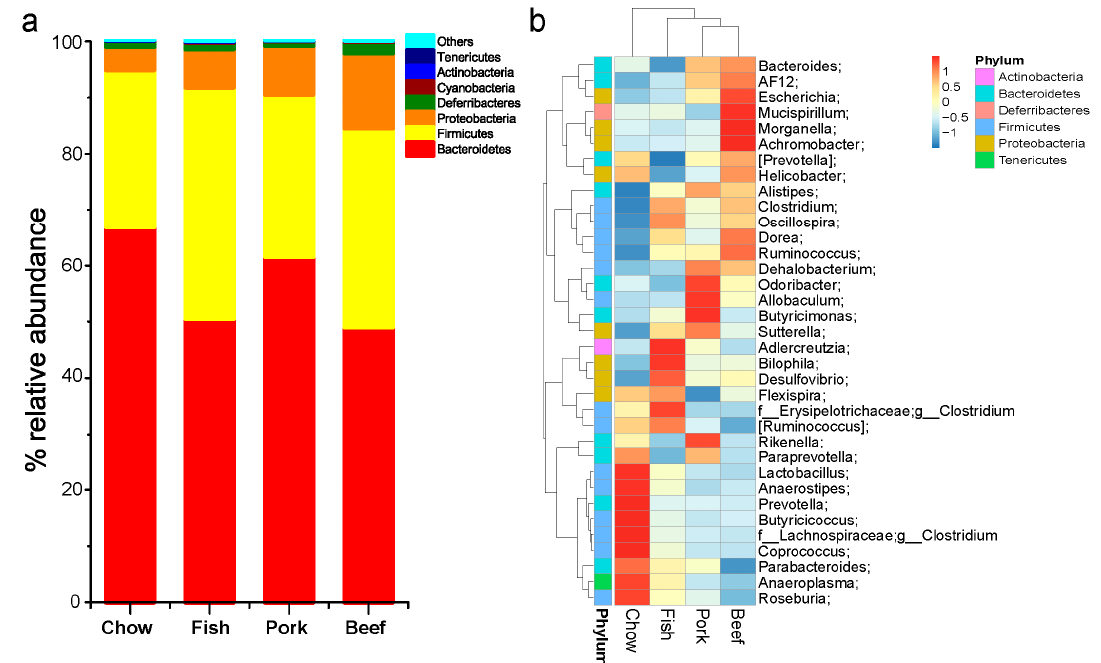
Figure 1. Taxonomic compositions of gut microbiota in mice fed laboratory chow, fish, pork, or beef. ( a ) Relative taxa abundance of gut microbiota of mice fed chow, fish, pork, or beef, summarized at the phylum level; ( b ) heatmap for cluster analysis of gut microbiota for the 35 most abundant genera in